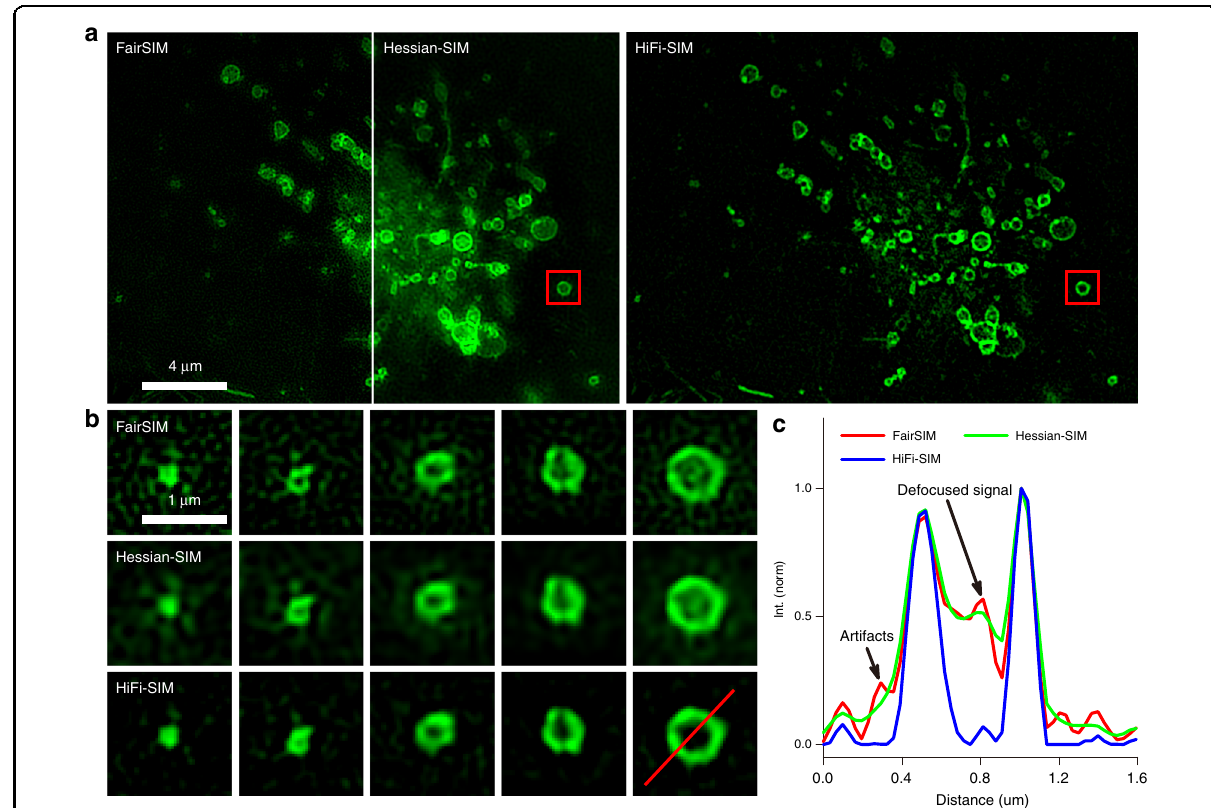
Fig. 6 Imaging of vesicle in live U2OS cells. a Comparison of SR images reconstructed by fairSIM (left), Hessian-SIM (middle), and HiFi-SIM (right). b Magni fi ed SR images of vesicles with different sizes using fairSIM (top), Hessian-SIM (middle), and HiFi-SIM (bottom). Note that vesicles with larger sizes reconstructed by fairSIM have obvious defocused background artifacts in the center and outside. Further performing the Hessian denoising procedure on the results of fairSIM can suppress the artifacts to a certain extent, but cause the center of the vesicles to be blurred. c Intensity pro fi les along the red line in